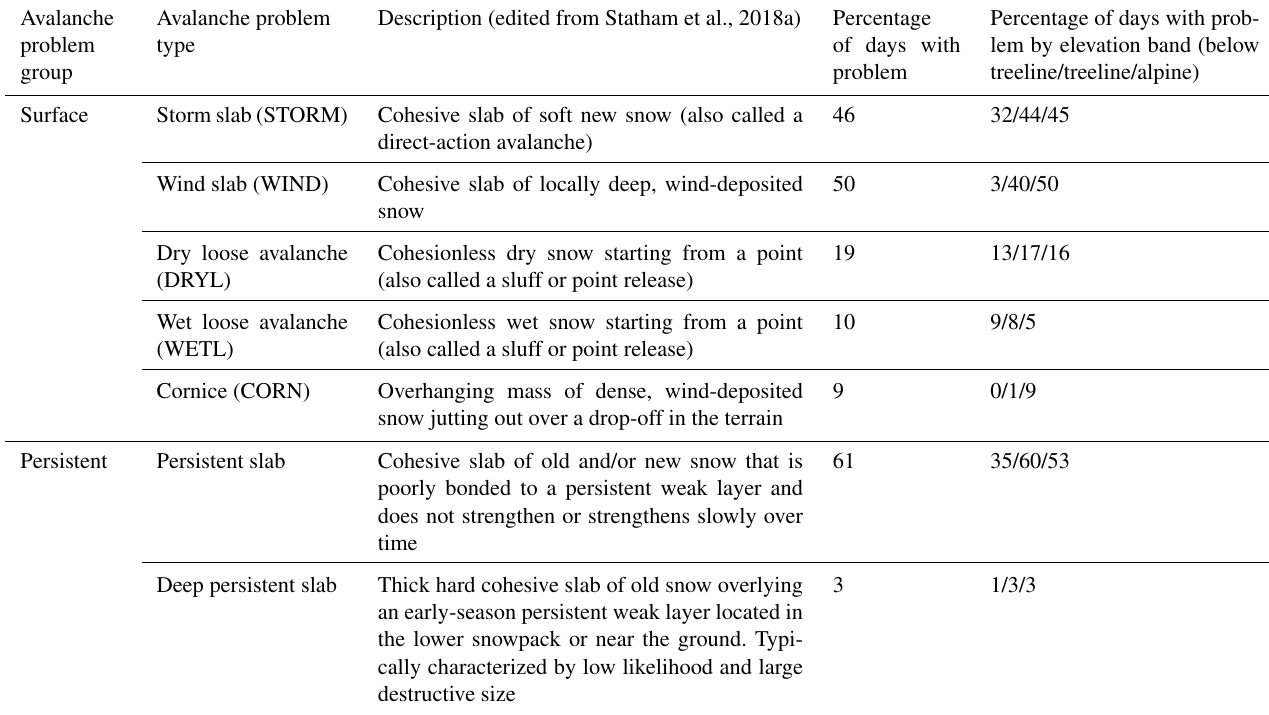
Table 1. Avalanche problem types and their prevalence in Glacier National Park between 1 December and 31 March for the 2012–2013 to 2019–2020